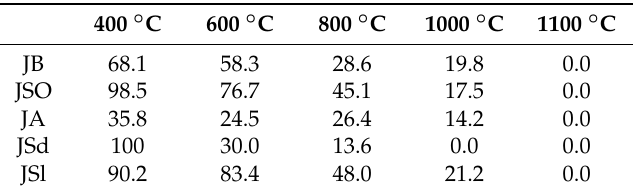
Table 2. Adsorption ratio (%) for Cs + onto rocks (0.5 g) calcined at various temperatures, as calculated based on the Cs + adsorption quantities without calcination (Figure 2).